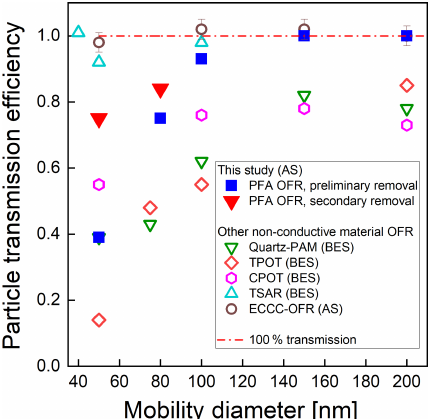
Figure 5. Variations in the concentration of OH as a function of photon flux at 254nm with (red solid points) and without ePTFE (black solid points) wrapped around the flow tube. Both experi- ments were done with the same OH reactivity.